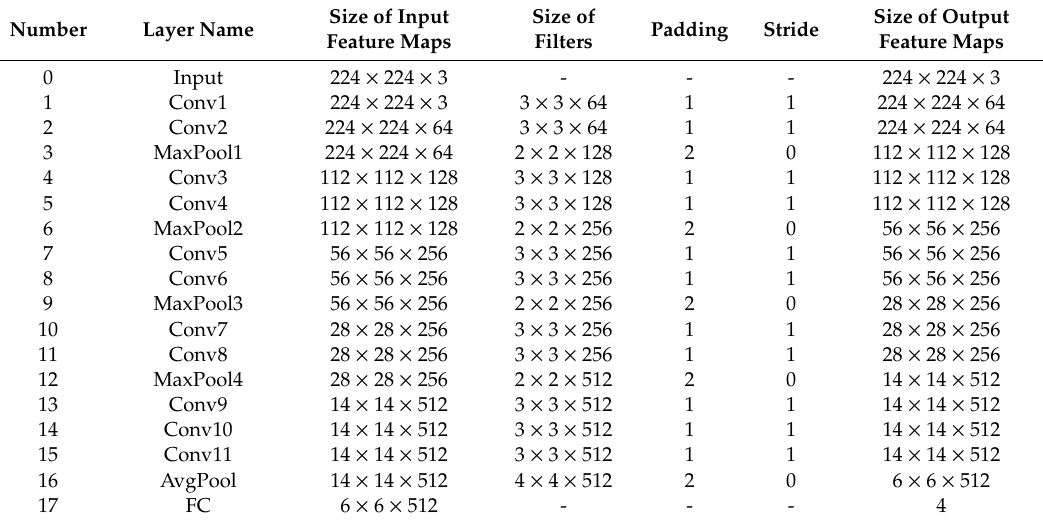
Table 4. Structural parameters of the ToolWearnet